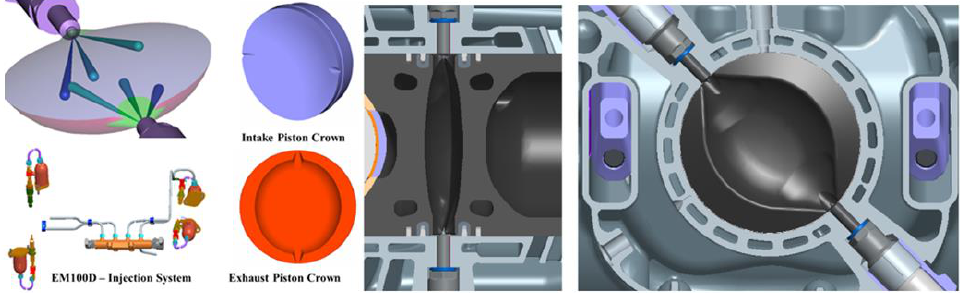
Figure 7. The ovoid combustion chamber.